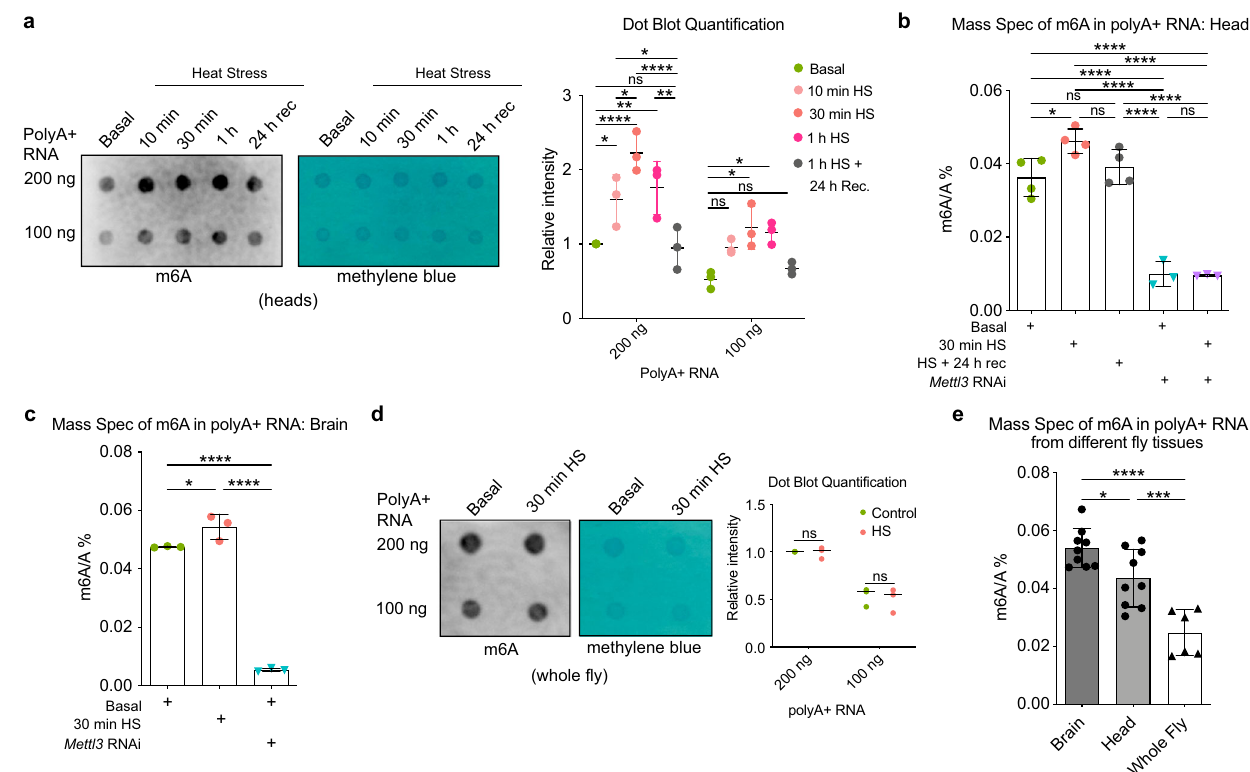
Fig.1|m 6 Alevelsareenrichedinthebrainandaremodulatedwithheatstress. a Dotblotassayof polyA+RNAm 6 Alevelsin fl yheads, w 1118 (BL5905),wasextracted immediately after HS at 38.5°C for 10min, 30min, 1h, and HS 1 and 24h recovery. Quanti fi cation of m 6 A levels relative to basal (intensity=1) and normalized to methylene blue. 1ul dots of 200 and 100ng polyA+ from the same replicate are blotted onto the membrane. n =3 biological replicates, 200 heads per sample con- dition and replicate. Data presented as mean±SD, * p <0.05, ** p <0.01, *** p <0.001, *** p <0.0001, two-way ANOVA with Sidak ’ s test. In a from left to right comparisons : p =0.0459, p <0.0001, p =0.0066, p =0.0314, p =0.0034, p <0.0001, p =0.0314, p =0.0138, p =0.0296,nsnotsigni fi cant. b LC-MS/MSanalysisofm 6 A/A%levelsfrom head polyA+ RNA in basal and HS 30min, in DaGal4> Mettl3 RNAi vs DaGal4 > mCherryRNAiconditions, n =3biologicalreplicatesfor Mettl3 RNAiconditions, n =4 for control animal conditions, 30 heads per replicate. Data presented as mean±SD, * p <0.05, **** p <0.0001, one-way ANOVA with Tukey ’ s test. In b from left to right comparisons : p =0.0266, p <0.0001, ns not signi fi cant, p <0.0001, p <0.0001, p <0.0001, p <0.0001, p <0.0001. c LC-MS/MS analysis of m 6 A /A levels in polyA+